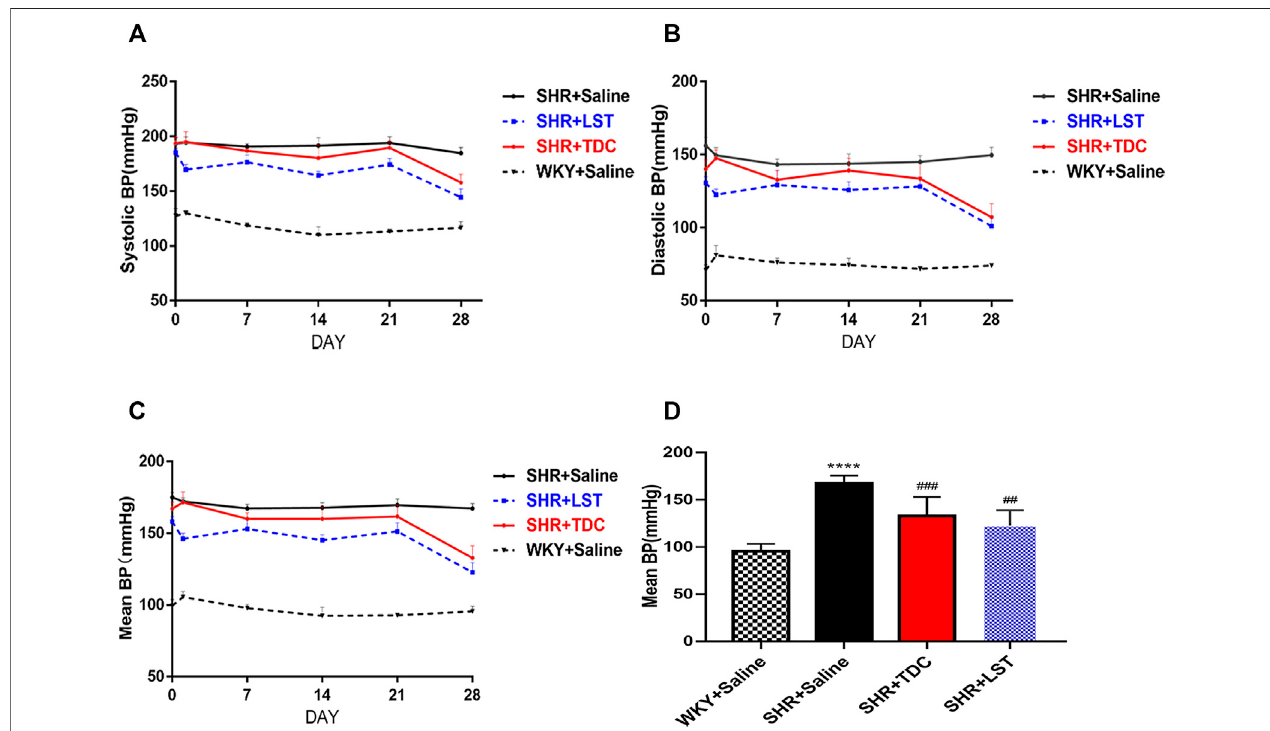
FIGURE 2 | Effects of TDC on noninvasive blood pressure in SHR (A – C) Representative data plots of SBP, DBP, and MBP measurements, respectively, over 4 weeks using the noninvasive tail-cuff method in conscious rats (D) Bar graph comparison of the MBP in the four rat groups at day 28. Data are expressed as mean